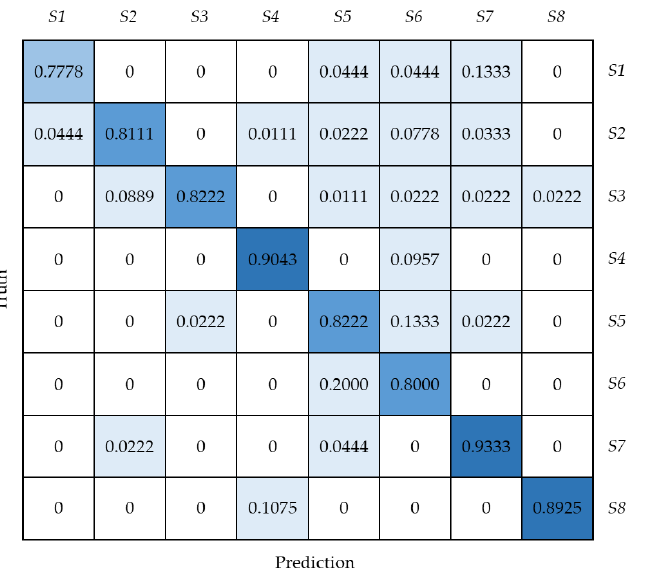
Figure 9. Accuracy of different damage scenarios by the CNN. For the left-end unit damage data set, 77.78% of the data in the first unit are identified correctly, 4.44% of the data are identified as ninth unit damage, 4.44% of the data are identified as tenth unit damage, 1.33% of the data are identified as asymmetric unit damage, 81.11% of the data in the second unit are identified correctly, 4.44% of the data are identified as the first unit damage, 1.11% of the data are identified as the sixth unit damage, 2.22% of the data are identified as the ninth unit damage, 7.78% of the data are identified as